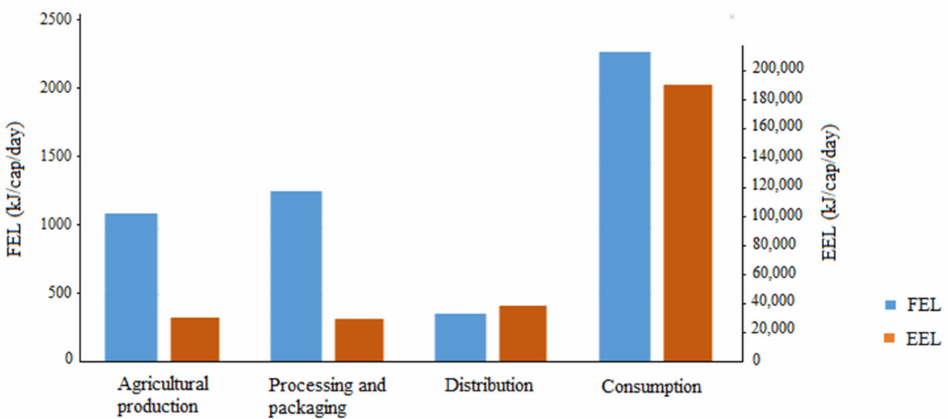
Figure 5. Food energy loss (FEL) and embodied energy loss (EEL) by stage of the food supply chain. Values expressed in kilojoules per capita per day (left and right ordinate